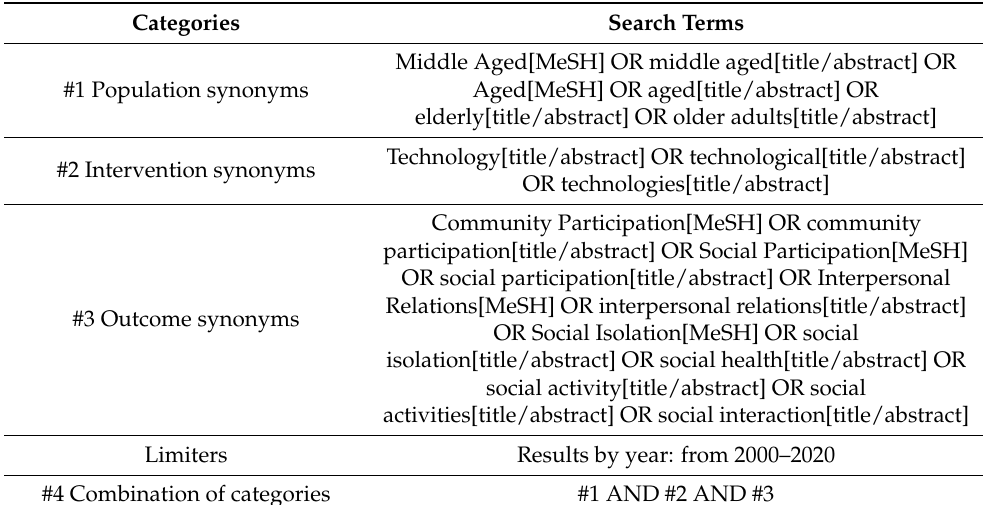
Table 1. Full search strategy of electronic database Medline